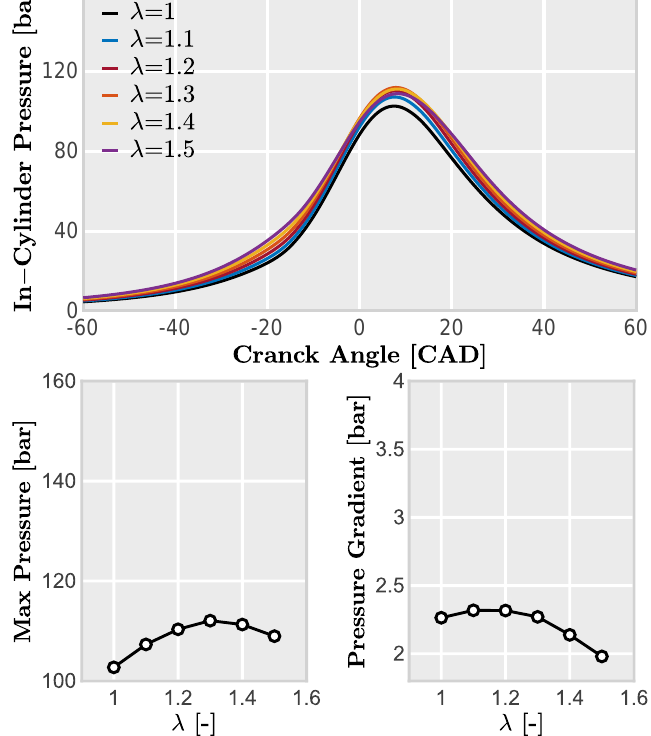
Figure 10. In-cylinder pressure evolution. Pressure profiles ( top ), maximum peak pressure ( bottom- left ), and maximum pressure change rate ( bottom-right ) for different air-to-fuel ratios considering methane fuel.